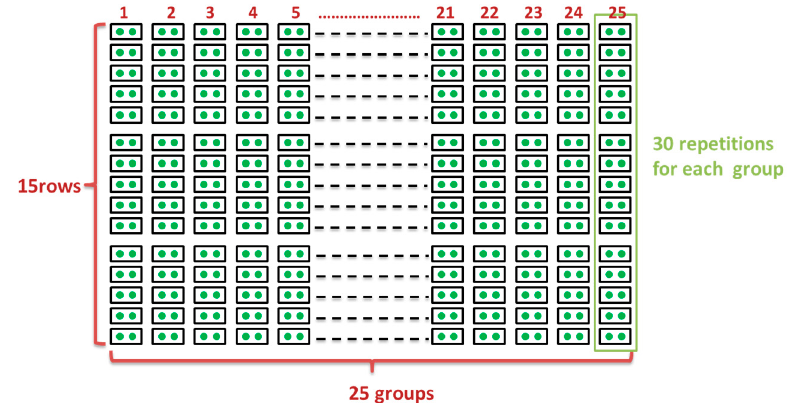
Figure 1. A graphical representation of the experimental site. Corresponding to the 25 treatment groups, there were 25 planting holes along the level trench. Two seedlings were planted in each hole, and 15 rows were in the slope direction. Each treatment group had 30 repetitions.